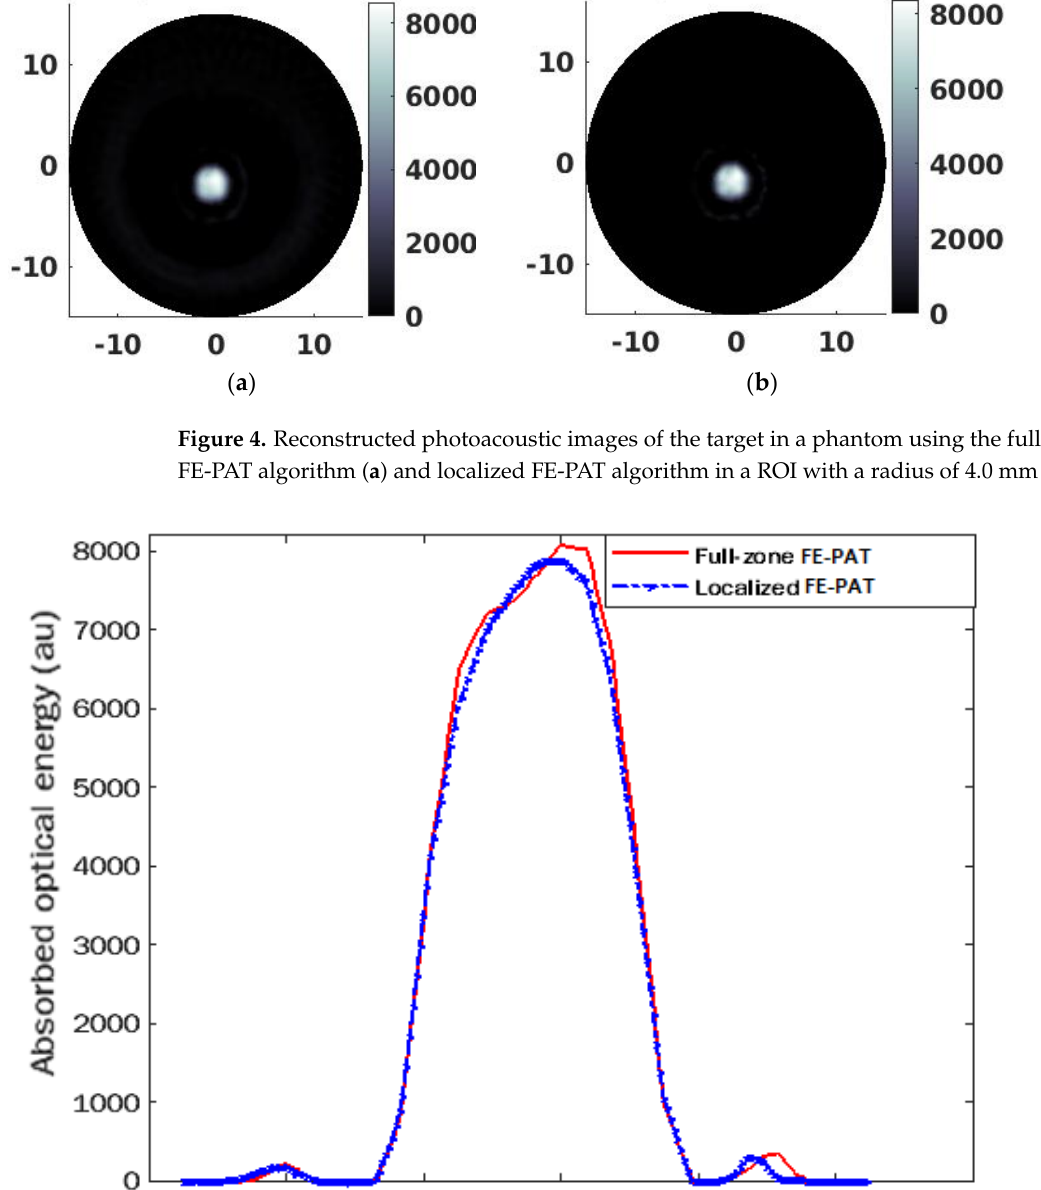
9 of 17 Table 1. Mesh parameters and performance comparison between conventional full zone-based FE- PAT algorithm and localized FE-PAT algorithm in various ROI sizes for simulation studies. Radius of ROI (mm) No. of ROI Nodes Time Cost (s) Target Size (mm) Error of Tar- get Size